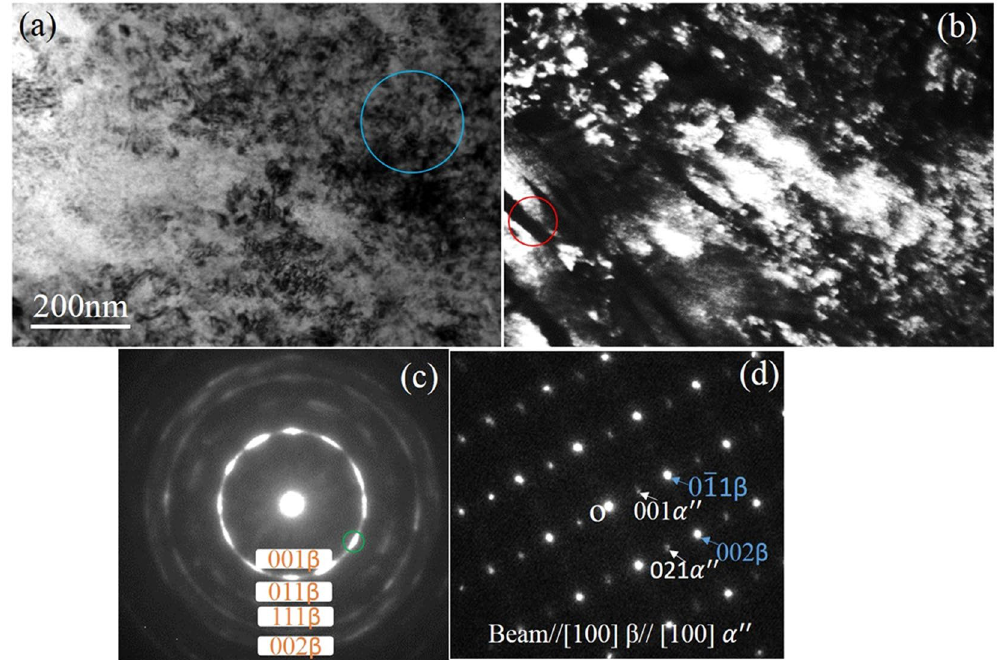
Figure 2. TEM analysis of the cold rolled Ti-9Mo-6W alloy. ( a ) BF-TEM image and ( c ) its indexed SAED pattern recorded from the blue circle marked region in ( a ). ( b ) DF-TEM image recorded using the green circle marked spot in ( c ) and ( d ) its indexed SAED pattern taken from the red circle marked area in ( b